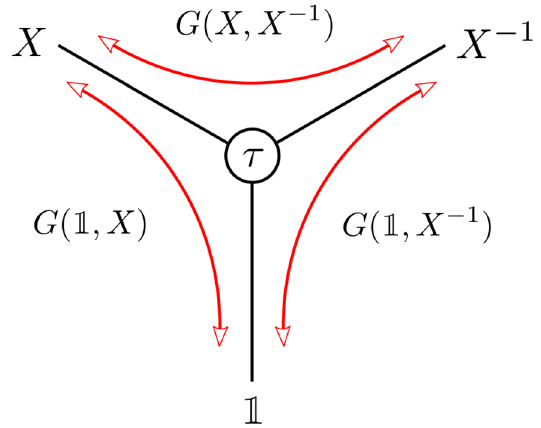
Figure 8 . A schematic Cayley graph for the relevant permutations and the geodesics connect- ing